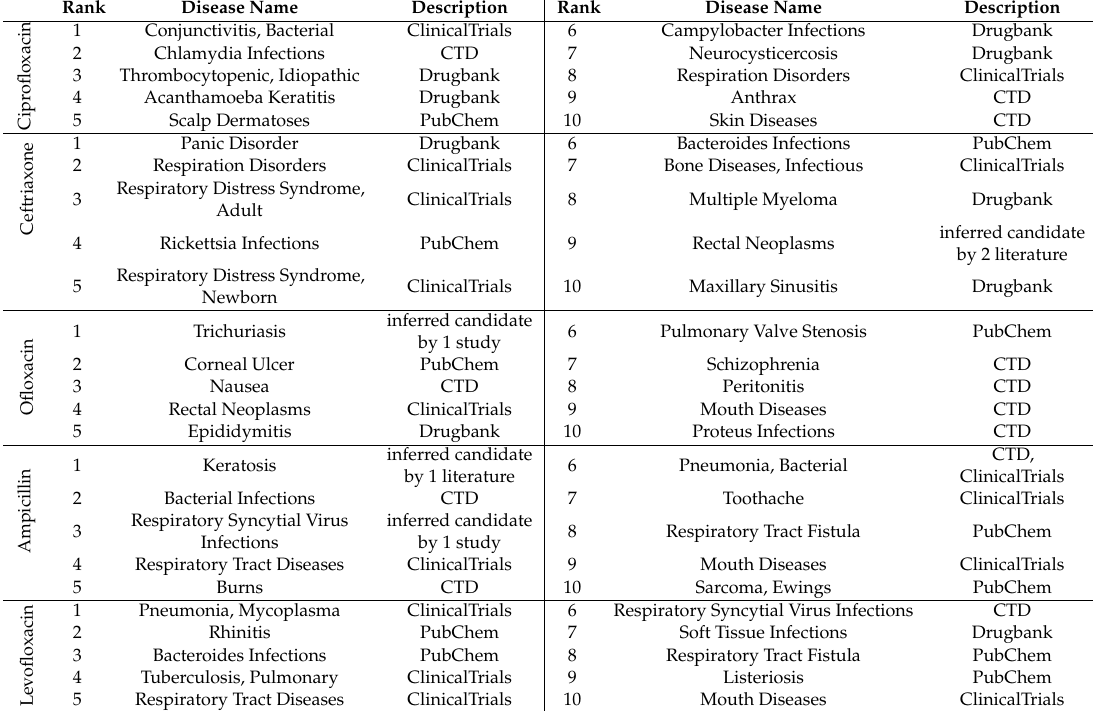
Table 4. The top 10 candidates of 5 popular drugs supported by databases. The associations involved